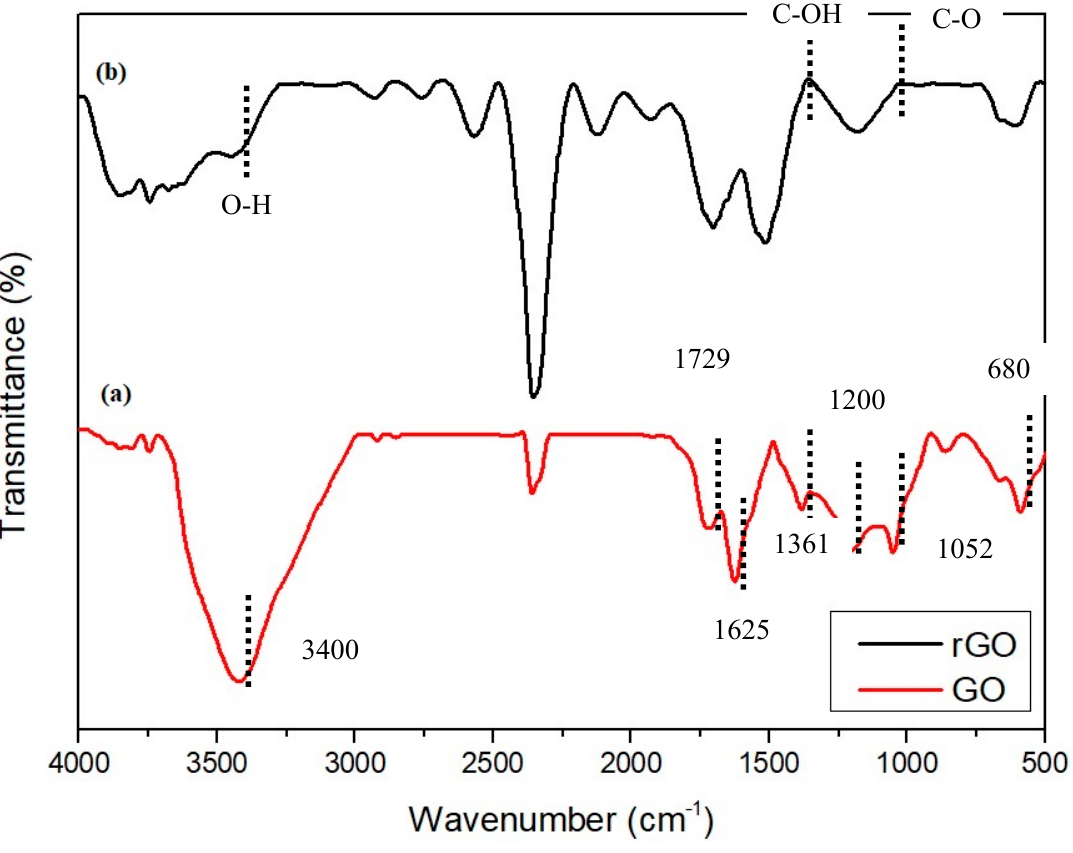
Figure 7. FTIR spectra of ( a ) GO and ( b ) rGO.